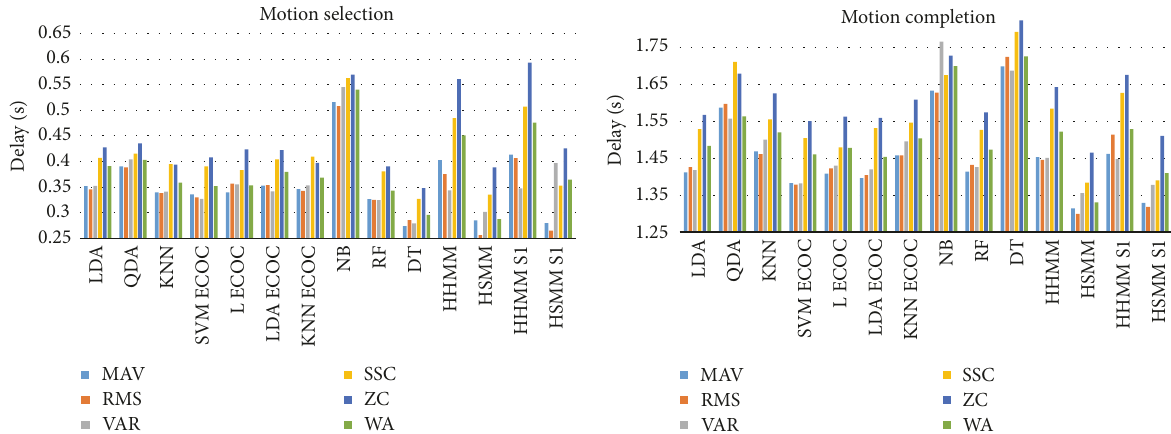
Figure 10: Motion selection (MS) and motion completion (MC) time. Mean values for MS time ranged from 0.25 s (HSMM-RMS) to 0.6s (HHMM S1-ZC) and for MC time ranged from 1.3 s (HSMM-RMS) to 1.8 s